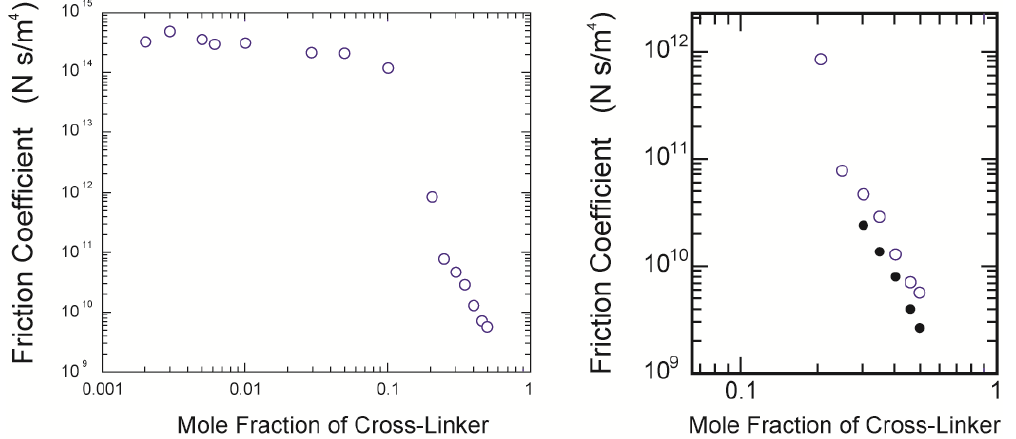
Figure 8. The double logarithmic plot of the cross-linker concentration dependence of the friction coefficient. The present results are plotted with the previous results shown in [4] ( left ); The close up view of the present results ( right ). The closed symbols in the right figure are the calculated values using Equation